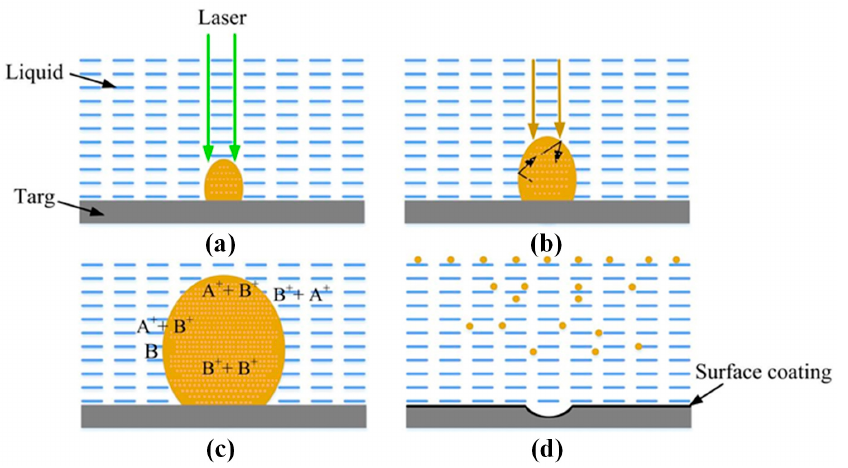
Figure 4. Evolution of laser-induced plasmas in liquids; ( a , b ) high-temperature chemical reaction between the target ablation; ( c ) the laser-induced plasma and the liquid; ( d ) chemical reaction inside the liquid. Reprinted/adapted with permission from Ref. [33]. Copyright 2007, Elsevier.